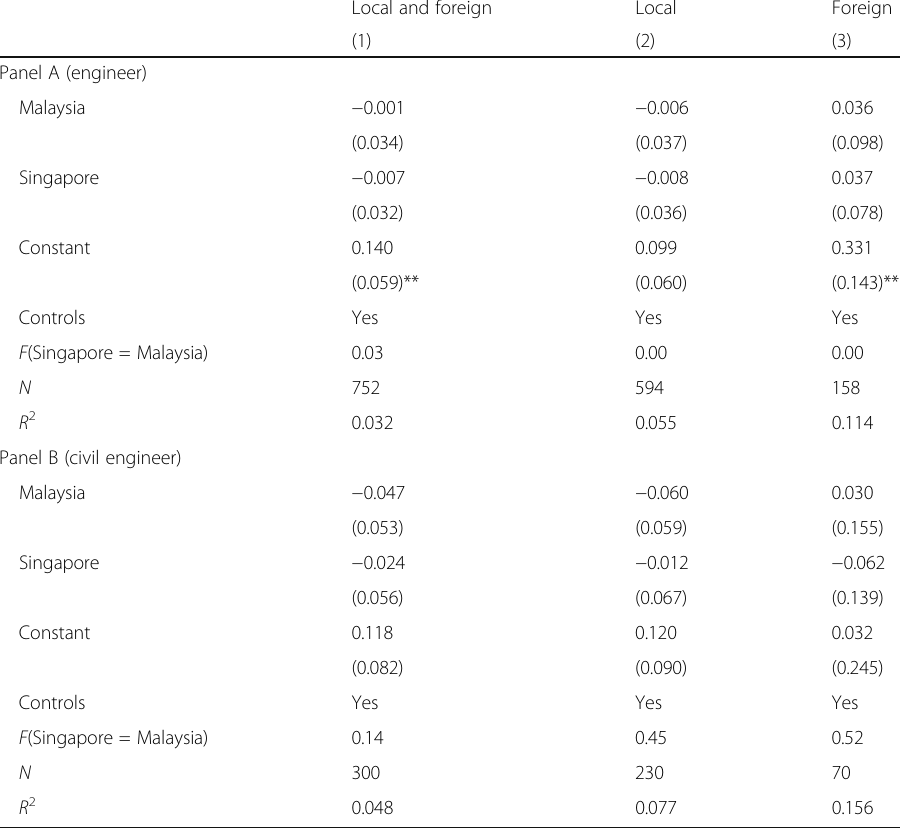
Table 6 Dependent variable: if a resume is the first to receive a callback for an interview (engineer) Local and foreign Local Foreign (1) (2)